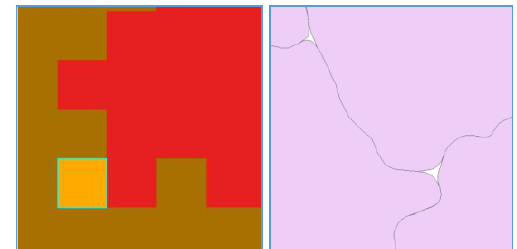
Figure 8. Common Errors in GIS Post-processing; Insignificant